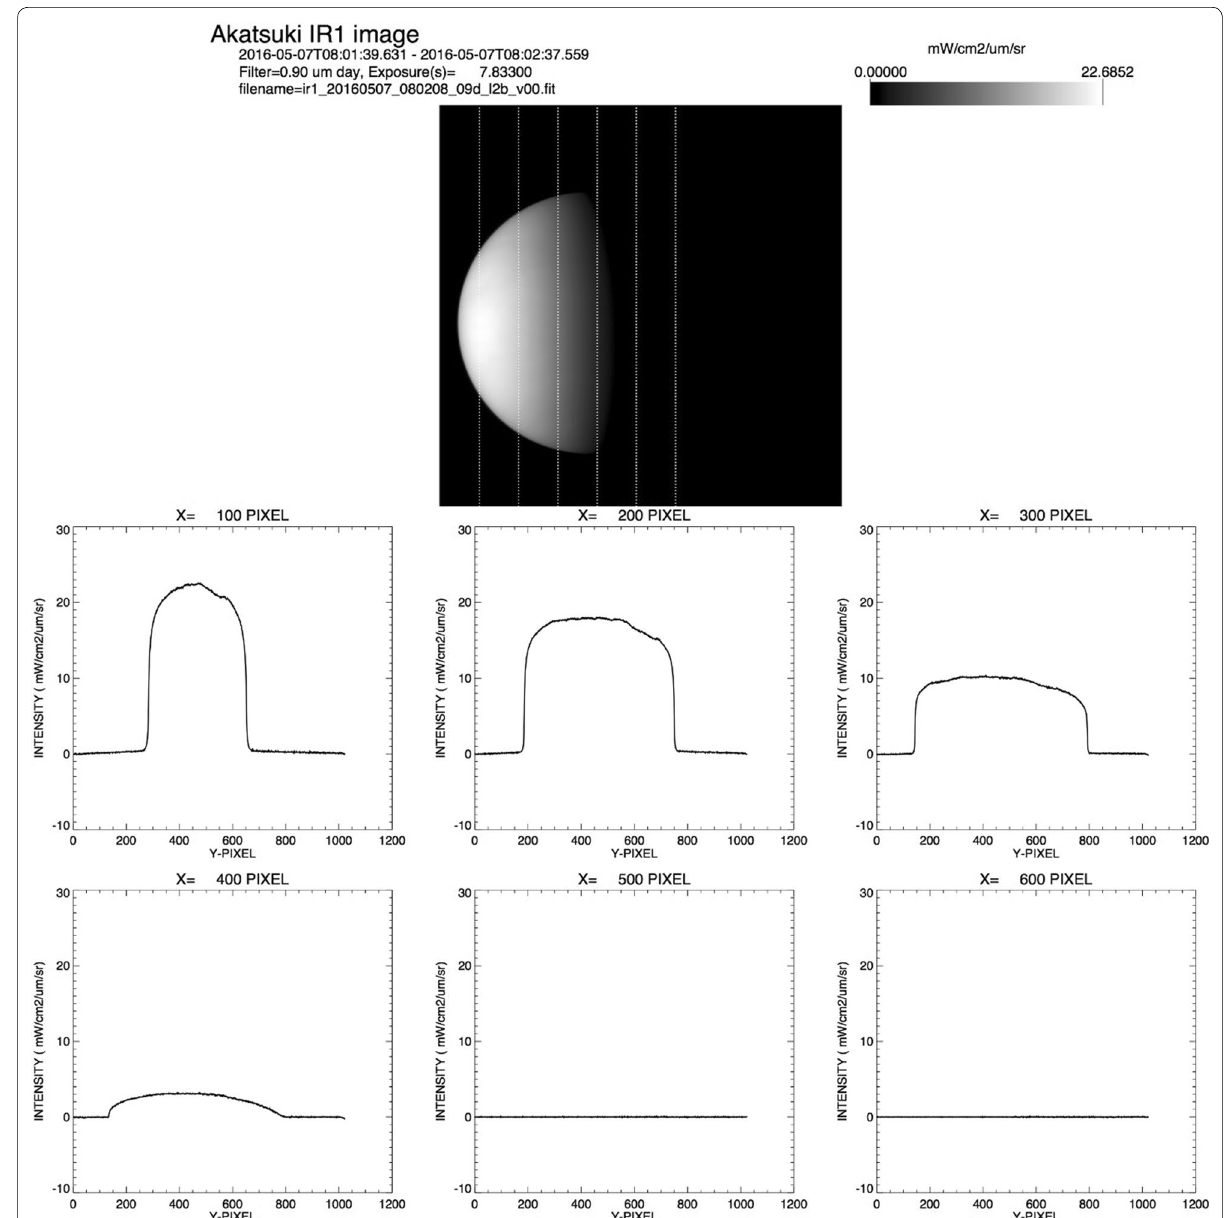
Fig. 6 Vertical cross sections of the Level 2 image after corrections shown in Fig. 4b. The smear‑like noise and the 513th bright line have been cor‑ rected. The six panels on the bottom show intensity along the vertical dotted line (at x the top